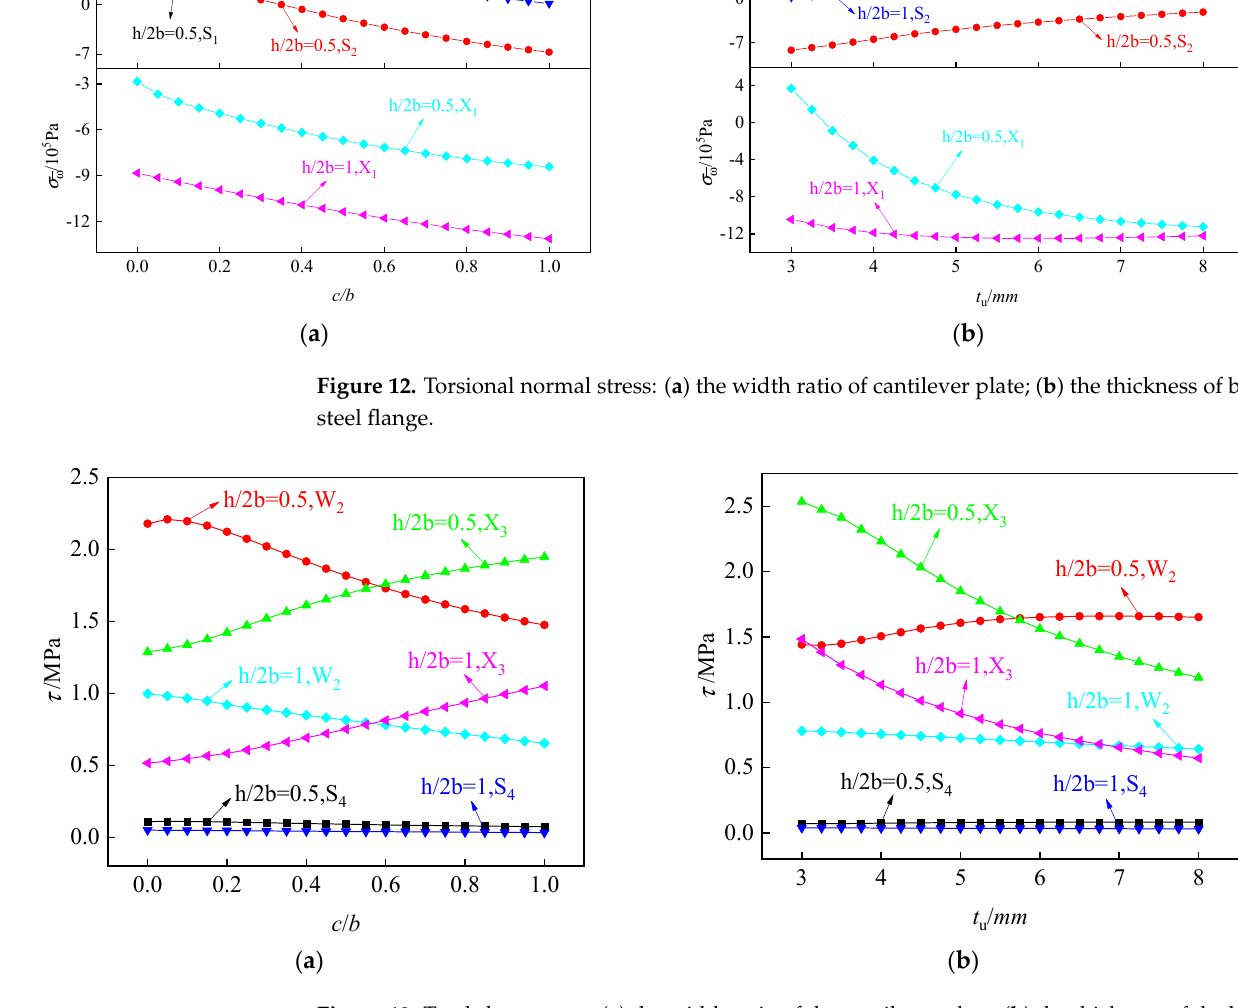
Figure 12. Torsional normal stress: ( a ) the width ratio of cantilever plate; ( b ) the thickness of bot- tom steel flange.